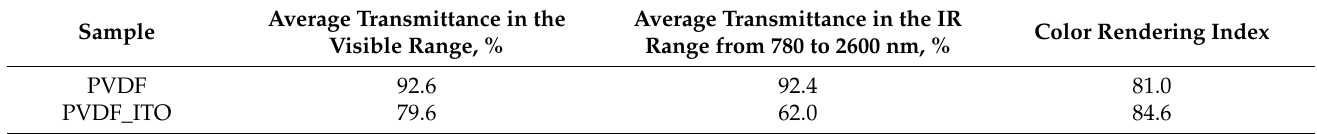
Table 4. Optical properties of experimental